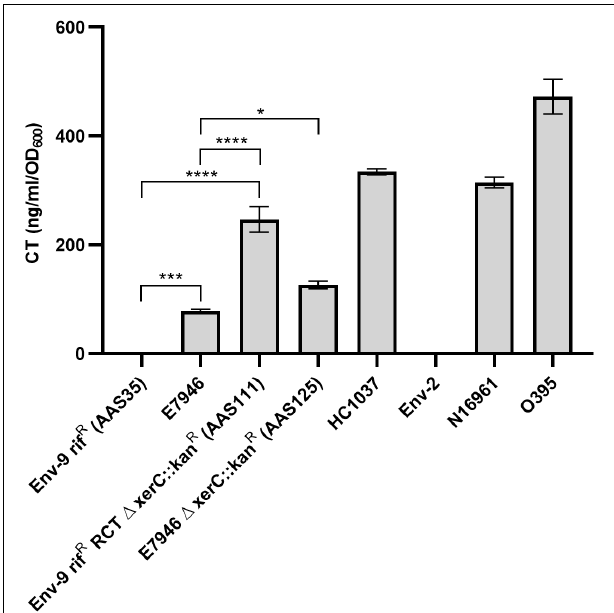
FIGURE 3 | Measurement of cholera toxin (CT) elicited by Vibrio cholerae strains in AKI media. GMI- based ELISA method was used to determine CT production by each V. cholerae strain. V. cholerae strains included in this assay were Env-9 rif R (AAS35), E7946, Env-9 rif R RCT (cid:49) xerC (AAS111), E7946 (cid:49) xerC (AAS125), a Haitian clinical isolate HC1037, a Haitian non-toxigenic environmental isolate Env-2, N16961, and a classical strain, O395 with the latter two strains were used as positive controls. The results are represented in biological triplicates with mean CT production (ng CT ml - 1 OD 600 - 1 ) and are exhibited with standard deviations for each strain. Error bars indicate standard deviation. Asterisks represent statistically significant difference of indicated samples by one-way ANOVA followed by Tukey’s multiple comparison test ( ∗ p < 0.05, ∗∗∗ p < 0.001, and ∗∗∗∗ p <